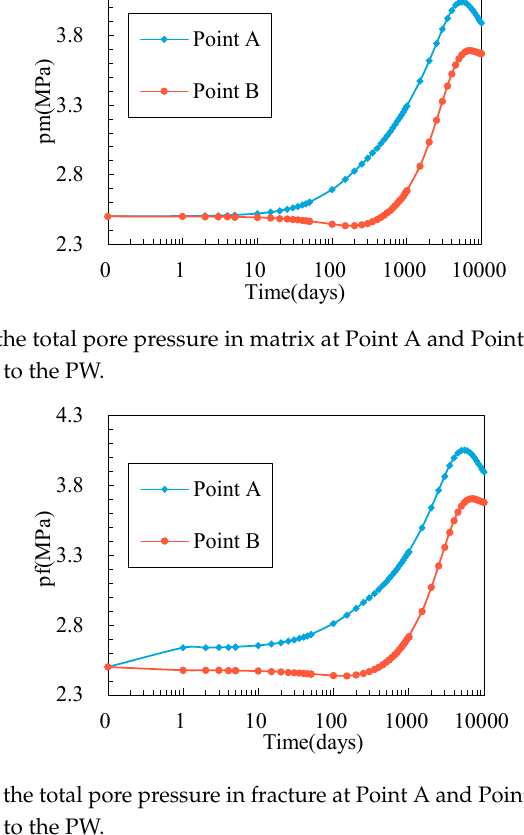
Figure 10. Evolution of the total pore pressure in fracture at Point A and Point B. Point A is close to the IW and Point B is close to the PW.